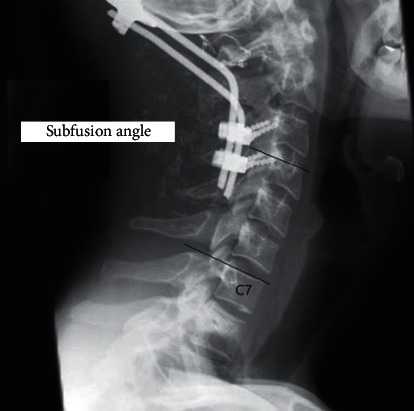
Lateral roentgenogram following POCF showing the subfusion angle measurement.